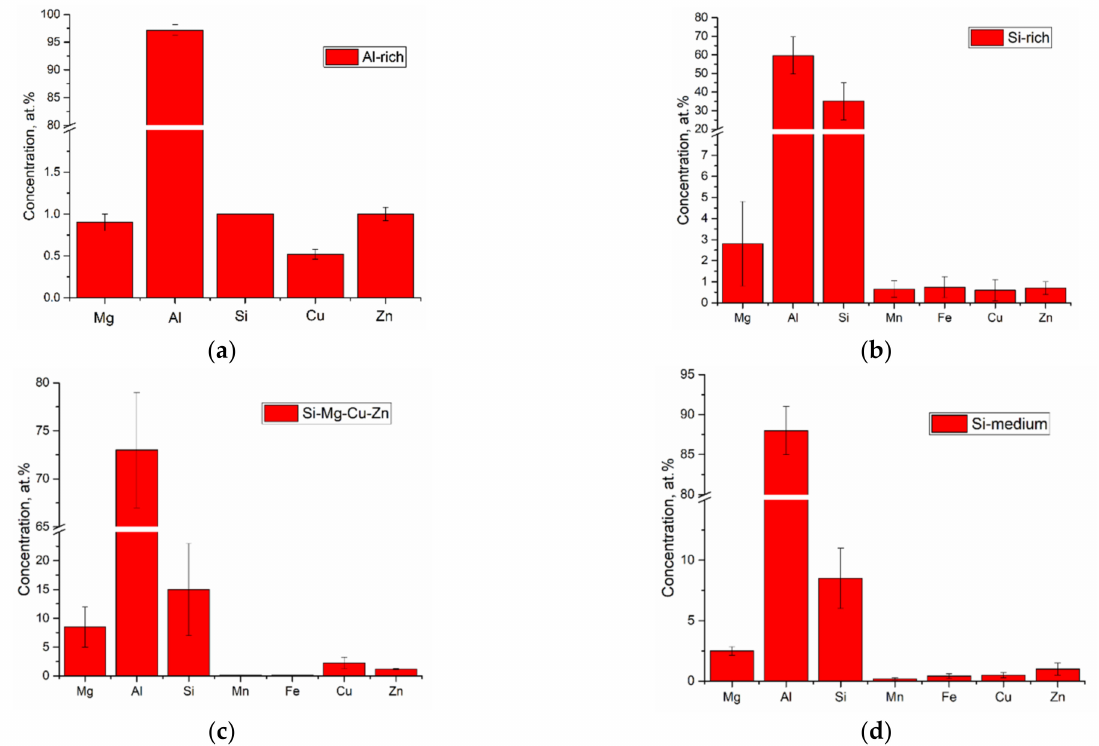
Figure 4. EDS element composition of particles shown in Figure 3. Al-rich ( a ), Si-rich ( b ), Si-Mg-Cu-Zn ( c ), Si-medium ( d ).